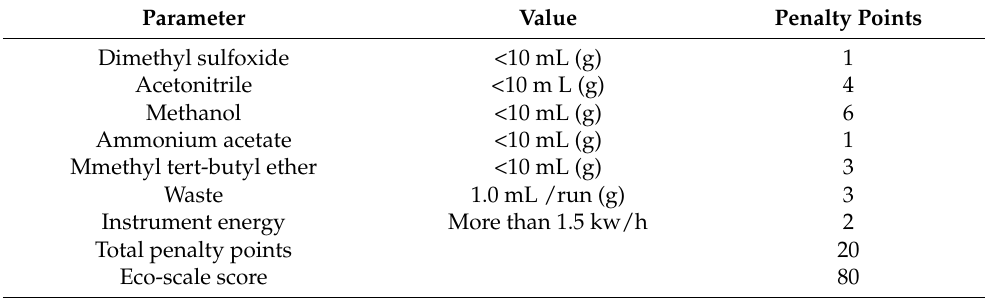
Table 5. The penalty points of the method for the determination and quantitation of the PX in